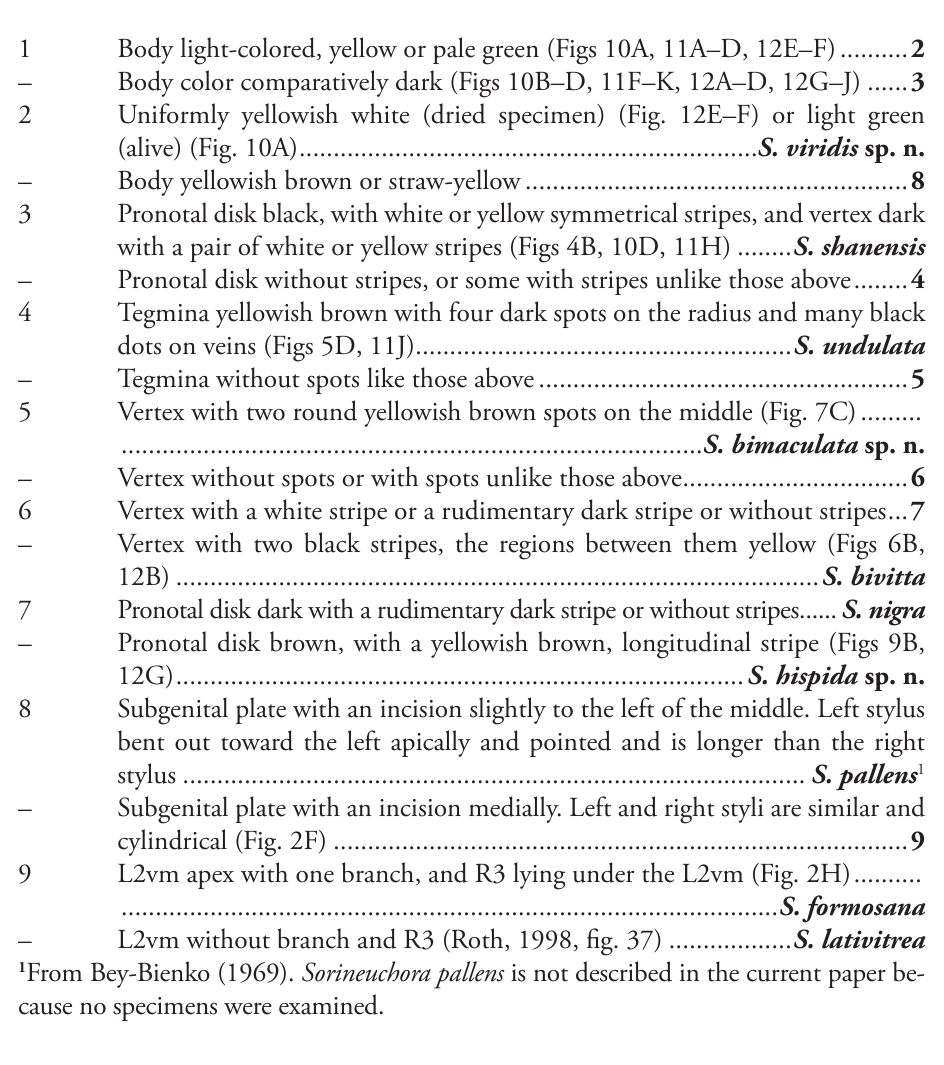
Key to the males of Sorineuchora from China 1 Body light-colored, yellow or pale green (Figs 10A, 11A–D, 12E–F) .......... 2 – Body color comparatively dark (Figs 10B–D, 11F–K, 12A–D, 12G–J) ...... 3 2 Uniformly yellowish white (dried specimen) (Fig. 12E–F) or light green (alive) (Fig. 10A) ................................................................... S. viridis sp. n. – Body yellowish brown or straw-yellow ........................................................ 8 3 Pronotal disk black, with white or yellow symmetrical stripes, and vertex dark with a pair of white or yellow stripes (Figs 4B, 10D, 11H) ........ S. shanensis – Pronotal disk without stripes, or some with stripes unlike those above ........ 4 Tegmina yellowish brown with four dark spots on the radius and many black dots on veins (Figs 5D, 11J) ....................................................... S. undulata – Tegmina without spots like those above ...................................................... 5 Vertex with two round yellowish brown spots on the middle (Fig. 7C) ......... – Vertex without spots or with spots unlike those above ................................. 6 Vertex with a white stripe or a rudimentary dark stripe or without stripes ... 7 – Vertex with two black stripes, the regions between them yellow (Figs 6B, 12B) .............................................................................................. S. bivitta Pronotal disk dark with a rudimentary dark stripe or without stripes ...... S. nigra – Pronotal disk brown, with a yellowish brown, longitudinal stripe (Figs 9B, 12G) ................................................................................... S. hispida sp. n. 8 Subgenital plate with an incision slightly to the left of the middle. Left stylus bent out toward the left apically and pointed and is longer than the right stylus ........................................................................................... S. pallens 1 – Subgenital plate with an incision medially. Left and right styli are similar and cylindrical (Fig. 2F) .................................................................................... 9 9 L2vm apex with one branch, and R3 lying under the L2vm (Fig. 2H) .......... ................................................................................................ S. formosana – L2vm without branch and R3 (Roth, 1998, fig. 37) .................. S. lativitrea 1 From Bey-Bienko (1969). Sorineuchora pallens is not described in the current paper be- cause no specimens were